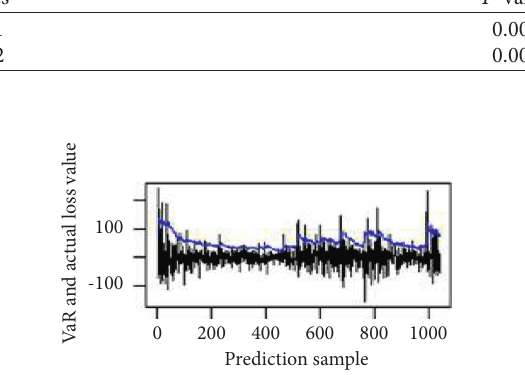
Figure 6: VaR value based on the GARCH-N model.